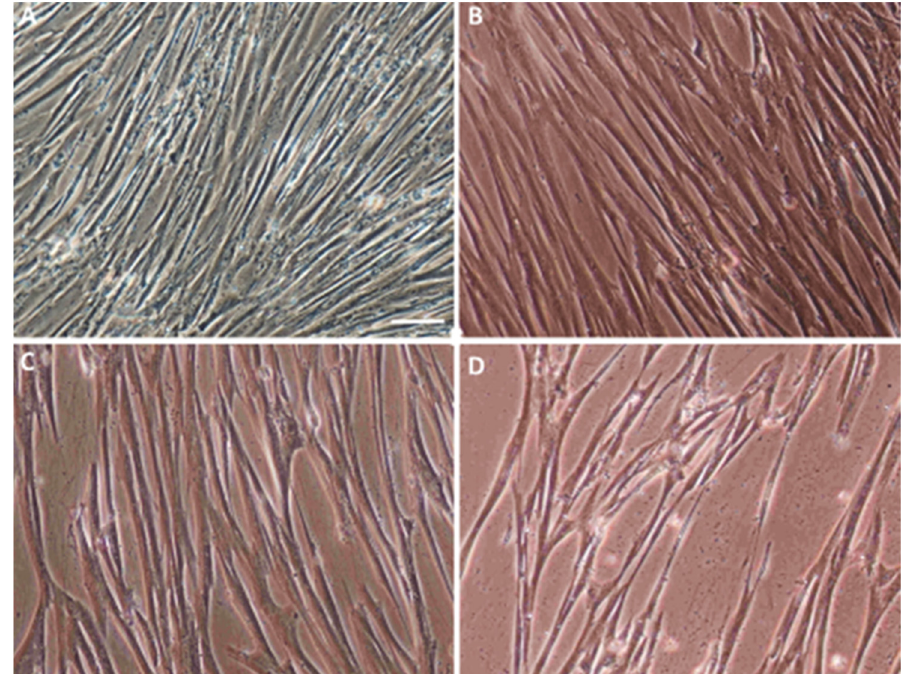
Figure 1. Characterization of an in vitro WJ-MSC culture. ( A ) Characteristic WJ-MSC fibroblast-like morphology. The WJ-MSC were cultured in a complete medium, as described in Materials and Methods. Changes in the cell morphology after a 12-day differentiation procedure in the control—C ( B ); empty vectors—EV ( C ); and full vectors—FV ( D ) group. Scale bar = 50 µm.